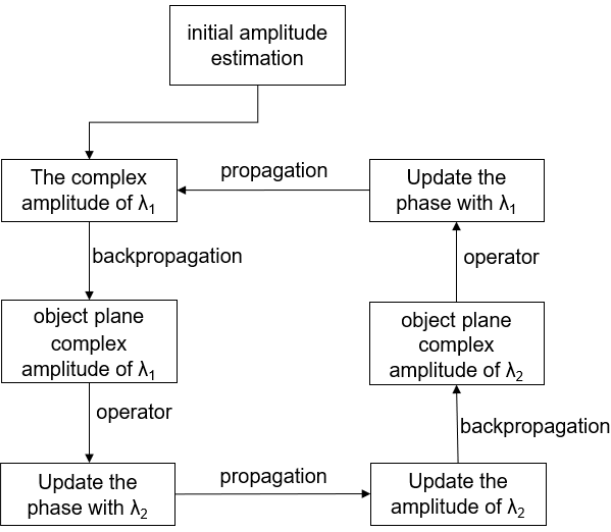
Figure 4. The two-wavelength iterative algorithm